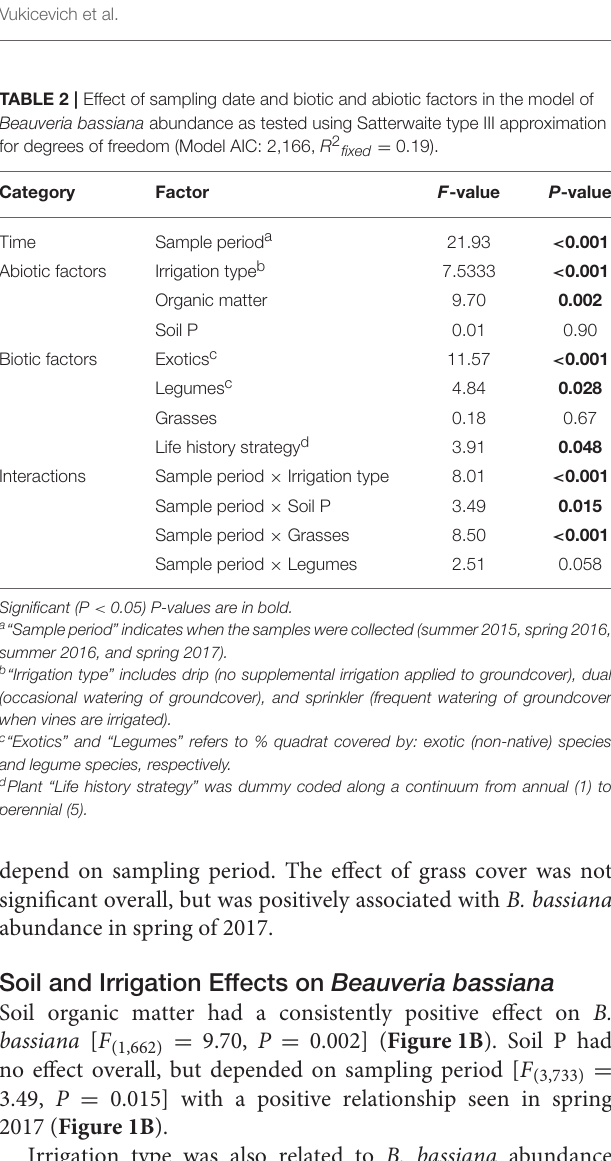
( Figure 3A ). Overall, Ilyonectria spp. increased with exotic plant cover [ F (1,675) = 11.25, P < 0.001], but this relationship